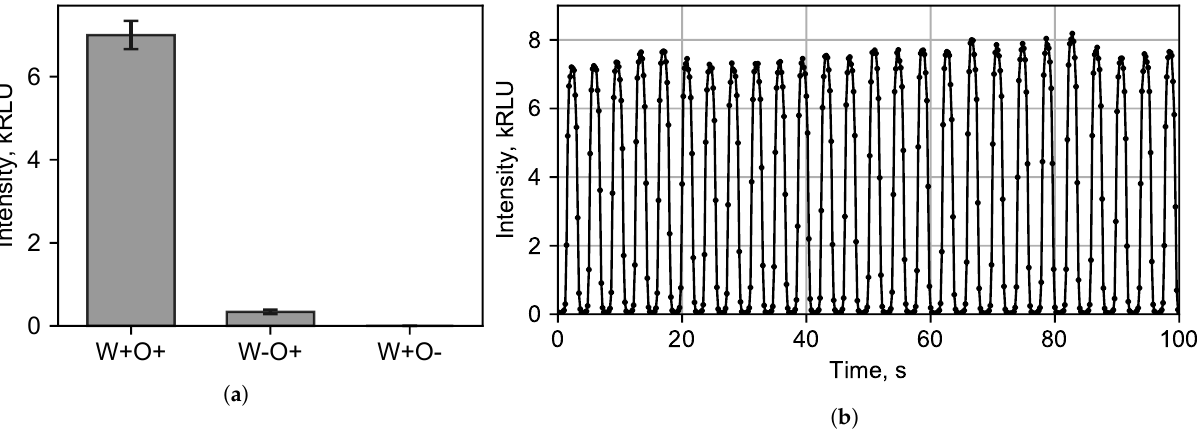
Figure 6. ( a ) Dependence of luminescence intensity on the presence of the tetrodecanal (+/ − ) in the carrier (O) and dispersed (W) phases. In the presence of tetradecanal (+), its concentration in the carrier and dispersed phase was 10 mM and 0.33mM, respectively. ( b ) The intensity of luminescence in time was recorded by the photomultiplier tube (PMT) 20 seconds after the start of the enzymatic cascade. Flares with a glow intensity in the region of 6–8kRLU were recorded at the moments when the droplet was opposite the PMT aperture. When the droplet was carried away with the flow and only the carrier phase appeared at the aperture, the glow intensity corresponding to the level of the PMT dark noise was recorded (approximately